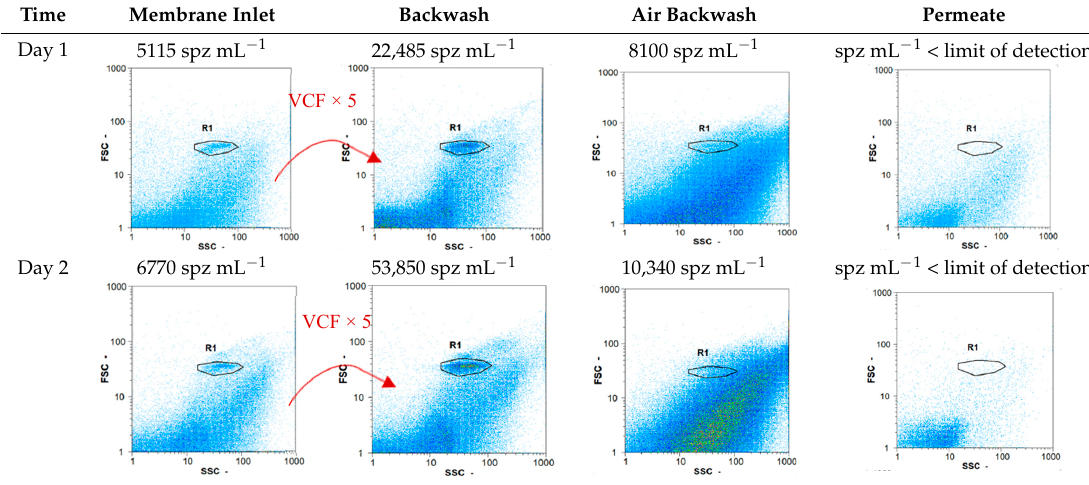
Table 6. Flow cytometry of spermatozoa—(J = 60 L h − 1 m − 2 and t filtration = 60 min for chronic pollution).